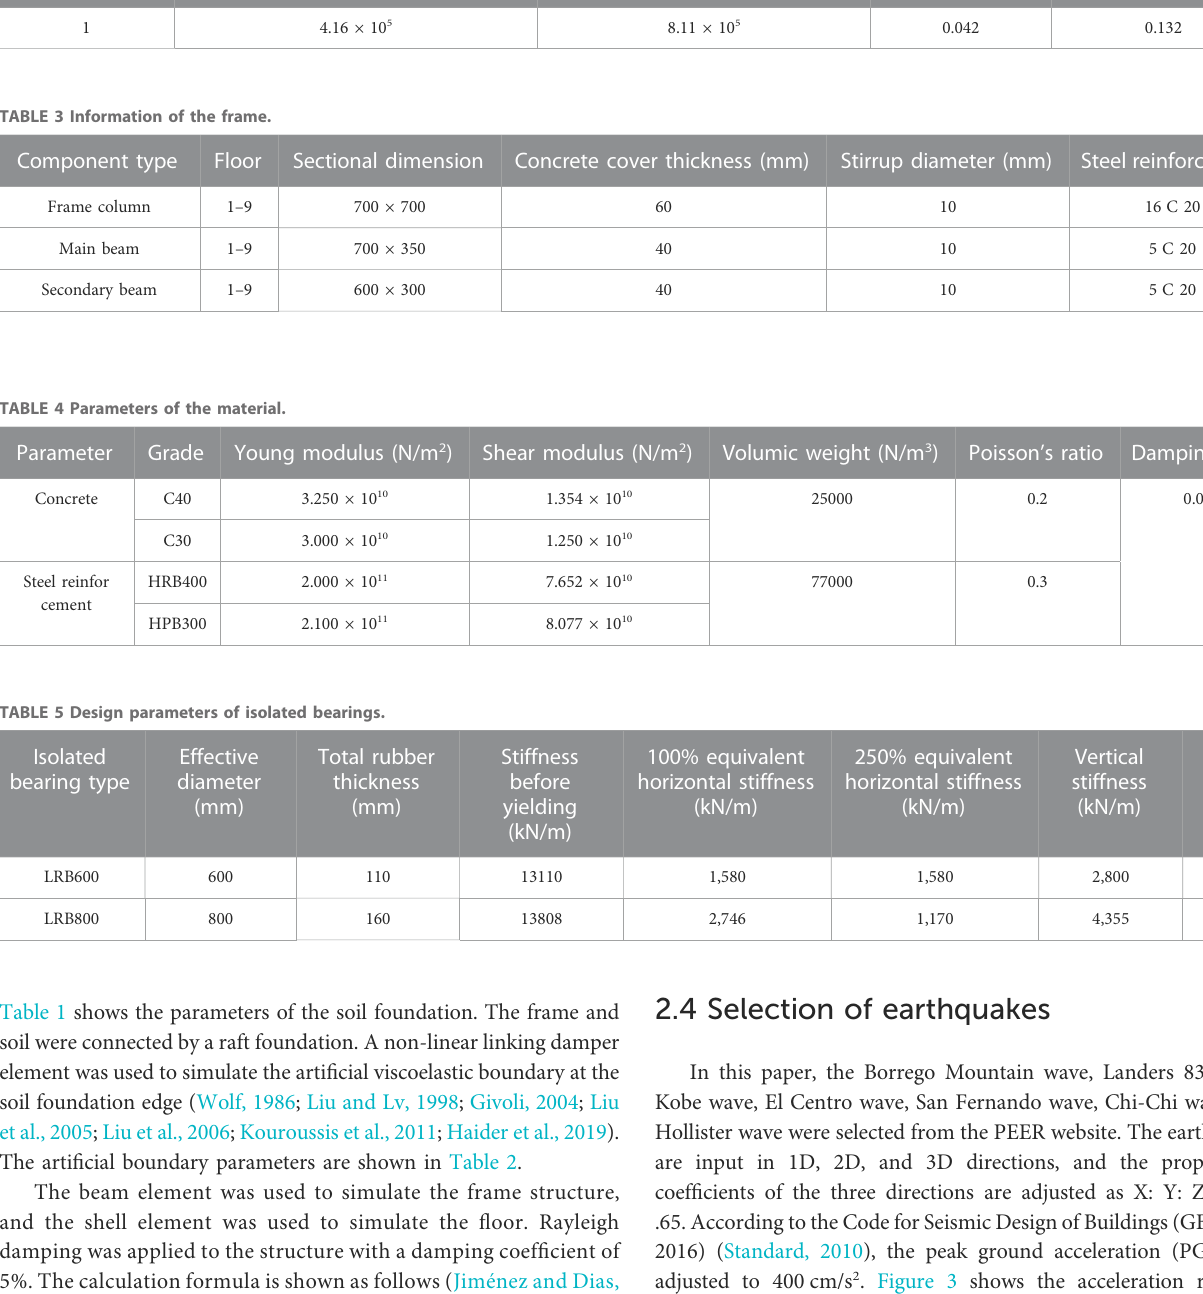
TABLE 2 Damping parameter of the arti fi cial boundary. Soil layer no.